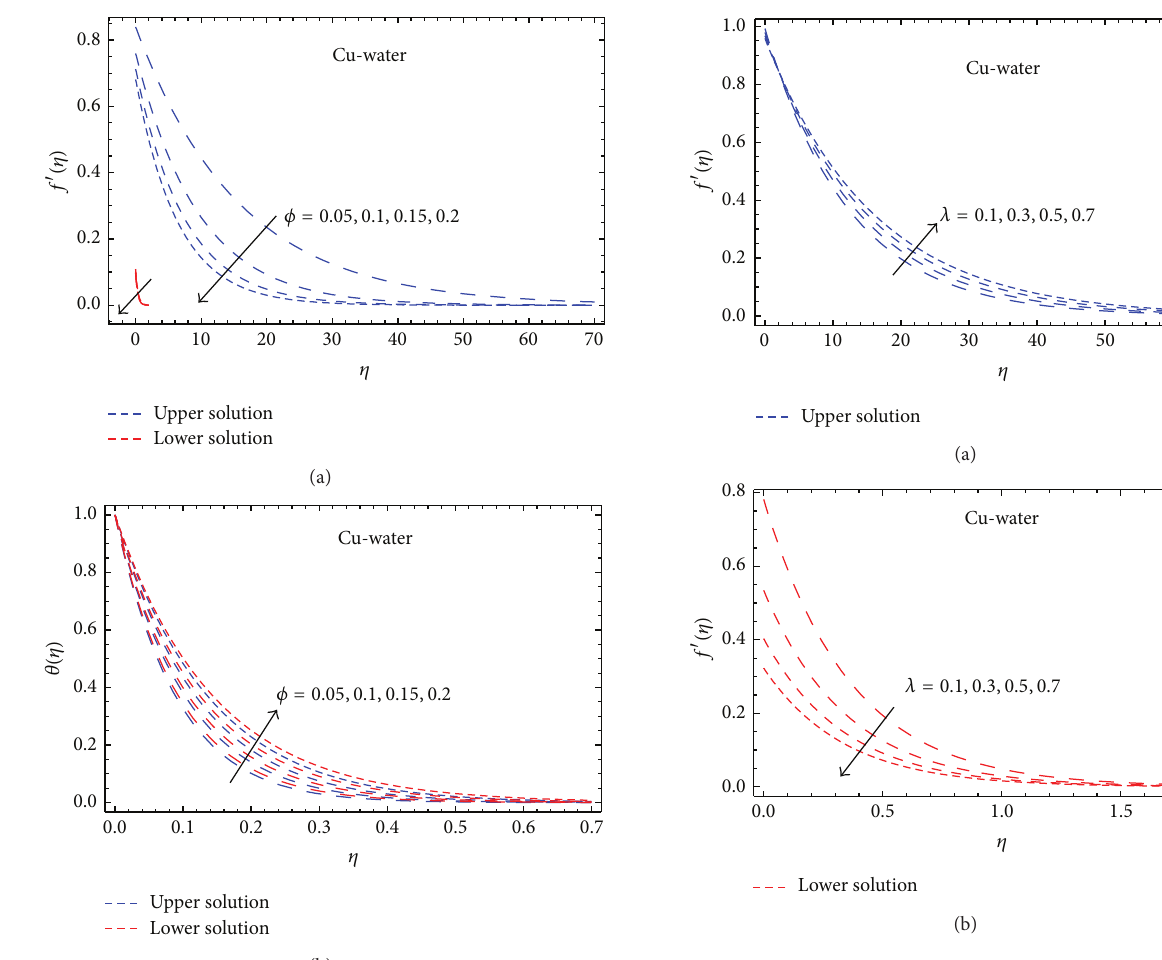
Figure 12: (a) Upper velocity solution for several values of 𝜆 at 𝑠 = 2 , 𝜙 = 0.1 , and 𝑀 = 1.5 . (b) Lower velocity solution for several values of 𝜆 at 𝑠 = 2 , 𝜙 = 0.1 , and 𝑀 = 1.5